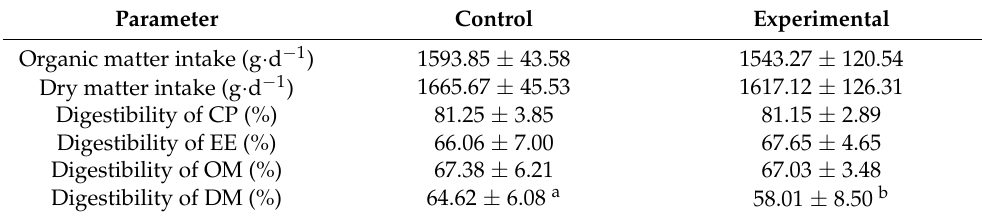
Table 3. Feed intake and nutrient digestibilities of sika